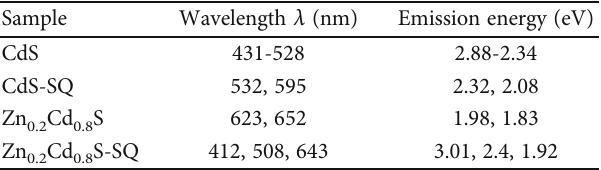
Figure 7: Raman spectra recorded with the 455 nm laser line for pure CdS and Zn Cd S solid solutions: (a) pure CdS 0.2 0.8 (synthetized by coprecipitation method); (b) pure CdS-SQ (synthetized by assisted sonochemical method); (c) Zn Cd S; 0.2 0.8 (synthetized by coprecipitation method); and (d) Zn Cd S-SQ 0.2 0.8 (synthetized by assisted sonochemical method). Table 3: Photoluminescence wavelength ( λ ) positions and its corresponding emission energies for the synthetized